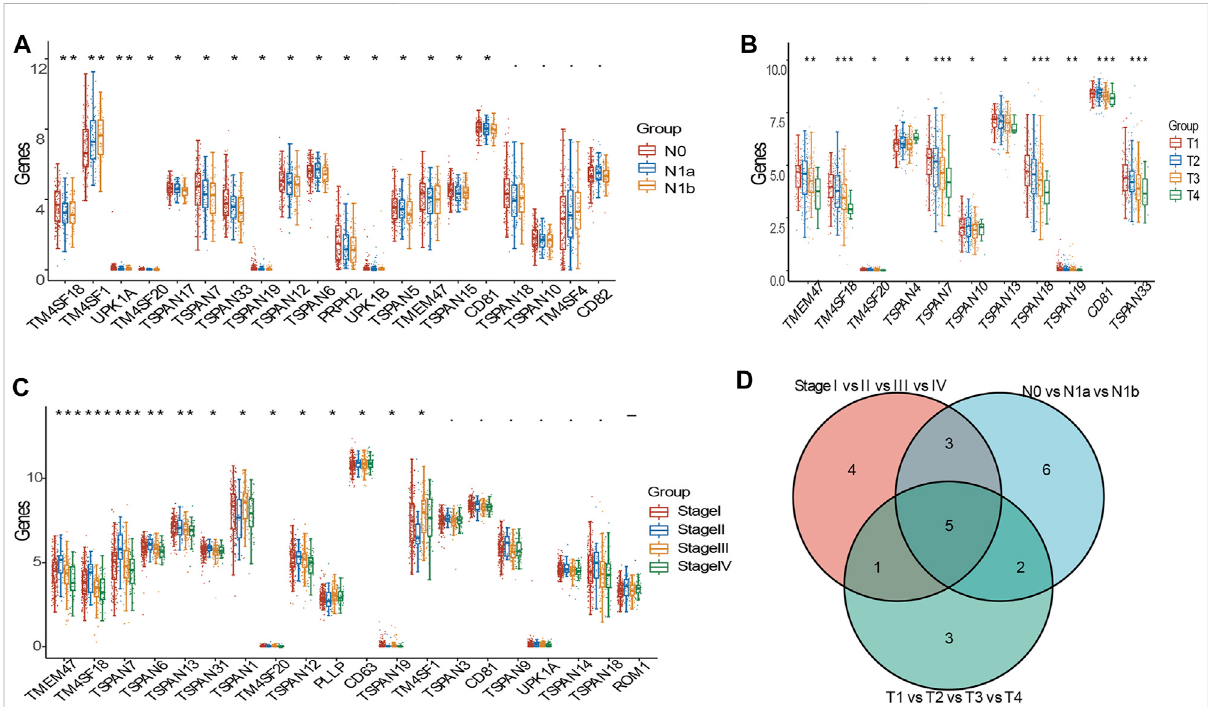
FIGURE 2 DEGsofTM4SFsinvariousclinicopathologicstagesinpatientswithPTC. (A) TM4SFmemberswithsigni fi cantlydifferentexpressioninvariousN stages; (B) and in various T stages; (C) and in various TNM stages; (D) The intersection of the three sets above of differently expressed genes. (* p < 0.05;** p < 0.01; and *** p <